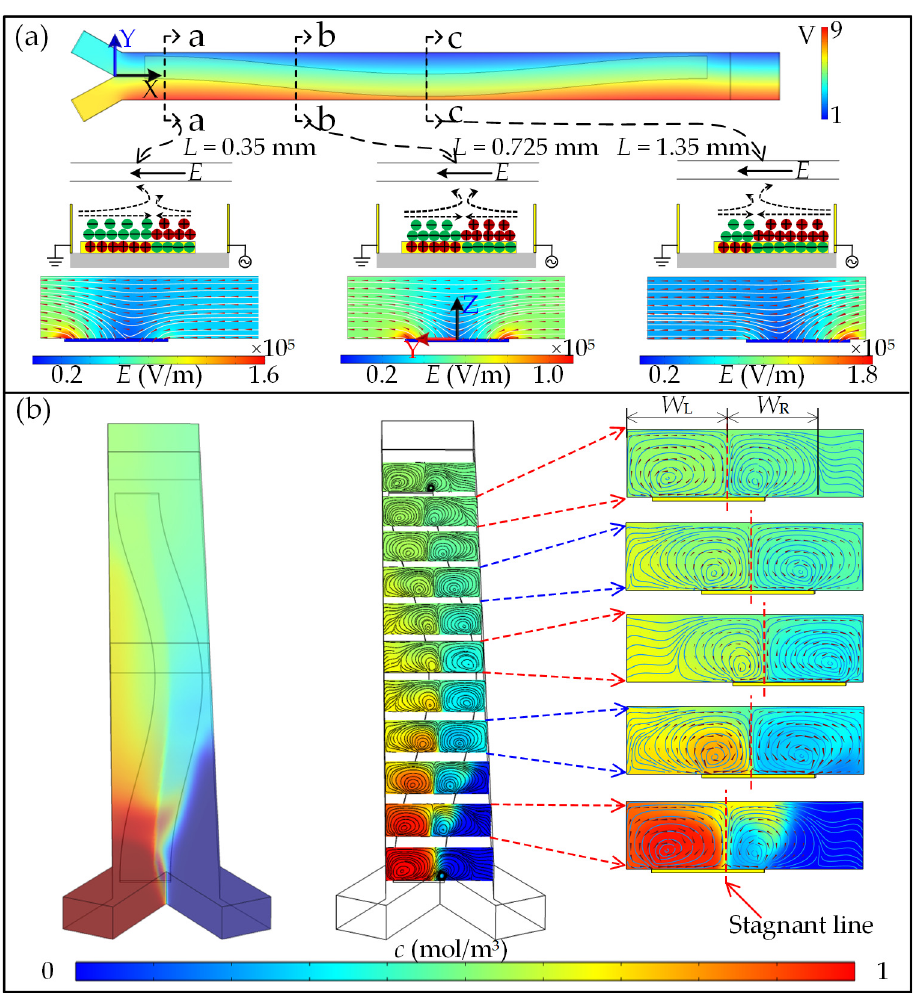
Figure 2. Mixing mechanism with asymmetric ICEO flow generated above a sinusoidally shaped floating electrode (SSFE): ( a ) electric field distribution at different sections in flow direction; ( b ) mi- crovortex reconfiguration and the corresponding micromixing in the main channel.